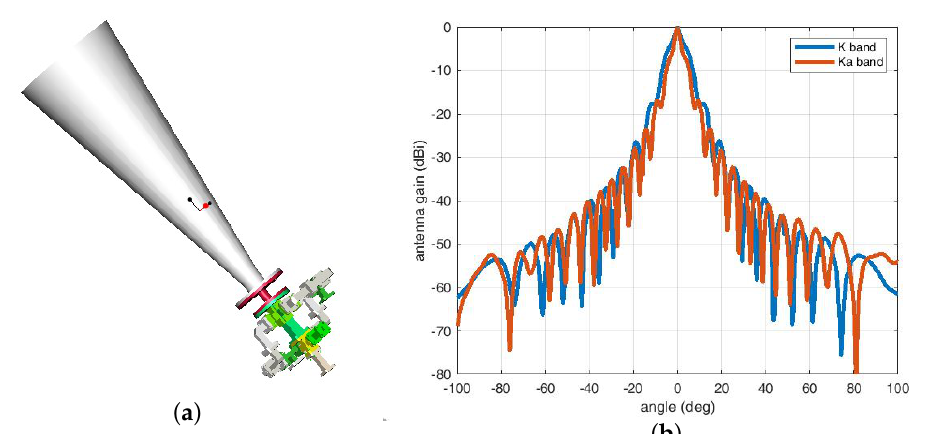
Figure 3. Illustration of the MWR transceiving antenna. ( a ) Three-dimensional antenna structure design including corrugated horn and K/Ka dual-polarization quadrature coupler. ( b ) Test results of the antenna pattern (radiation angle deviation from line-of-sight (LOS) direction vs. antenna gain) for both K and Ka